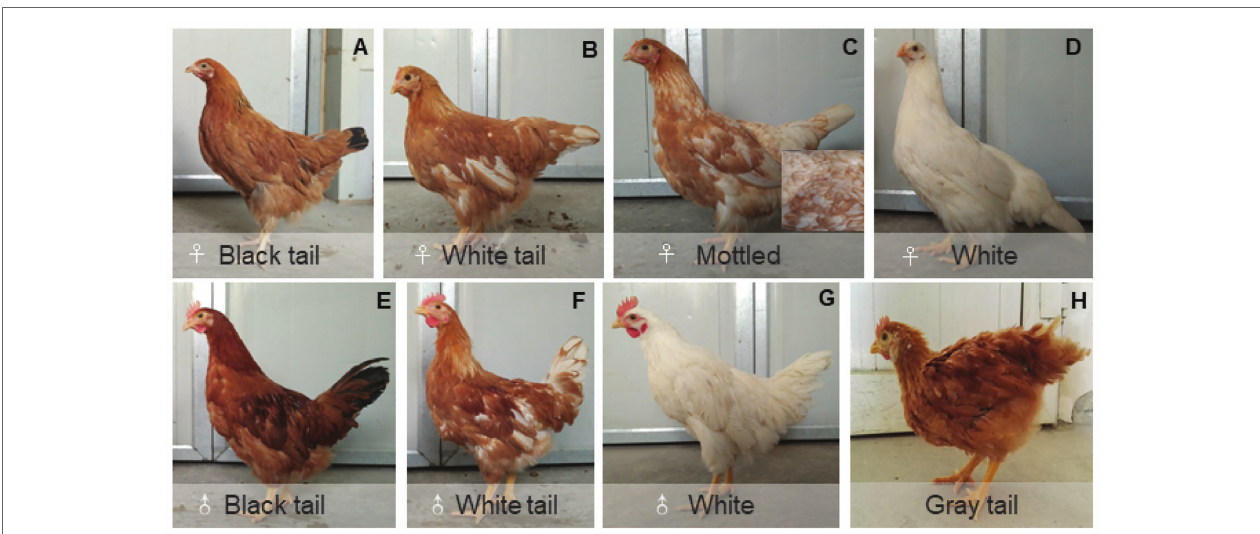
FIGURE 3 | Main feather color subtypes in the offspring of Dwarf chickens. (A–D) The different feather color phenotypes of Dwarf hens; (E–G) the different feather color phenotypes of Dwarf cockerels. (H) Some offspring have gray tail